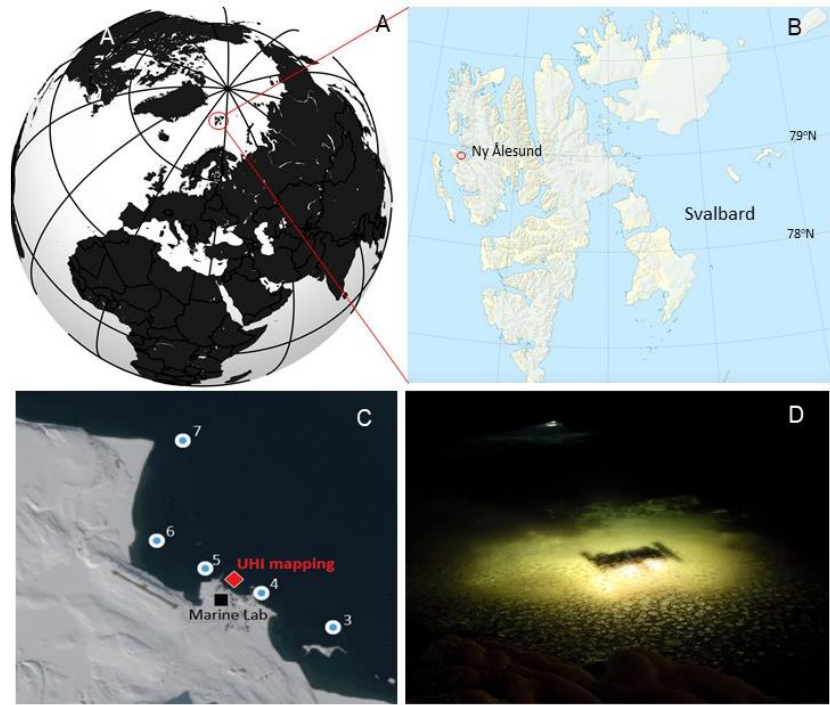
Figure 1. ( A , B ) Geoposition of Svalbard. ( C ) The ROV-UHI study site outside the Marine Lab, Ny Ålesund in Kongsfjord. Current UHI survey site (red diamond) in front of the Marine Lab (black square). Aerial hyperspectral imaging study sites from [13] are shown as blue points (3–7). ( D ) ROV-UHI underneath pancake ice. Credits: ( A , B ) based on [14]; ( C ) N. Summers (modified from https://geokart.npolar.no/, accessed 16 September 2022) and ( D ) N. Summers.